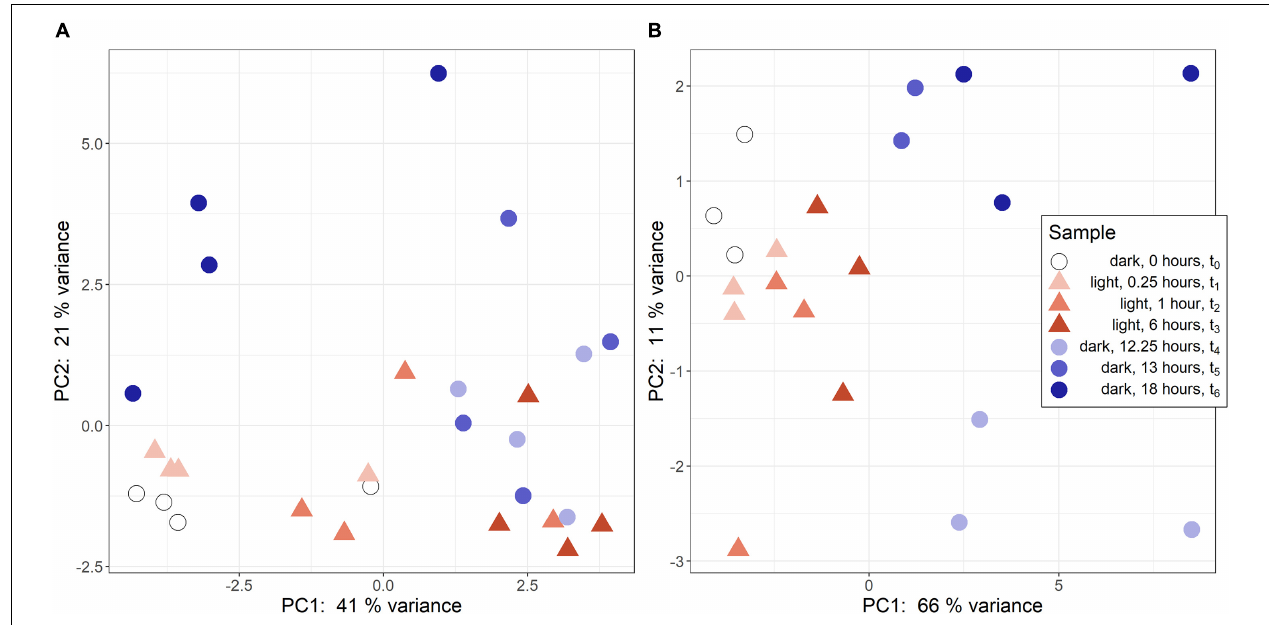
FIGURE 1 | Principal component analysis (PCA) of RNA-seq samples. (A) PCA of rlog scaled count data from R. lacicola . The steady-state light and early dark timepoints are quite similar in R. lacicola , as are steady-state dark and early light timepoints. (B) PCA analysis of A. photophilum strain MWH-Mo1. Light and dark samples are clearly distinct from each other along